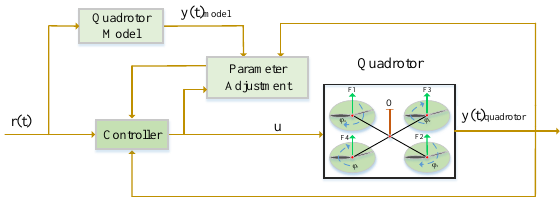
Figure 5. Block diagram of an adaptive controller